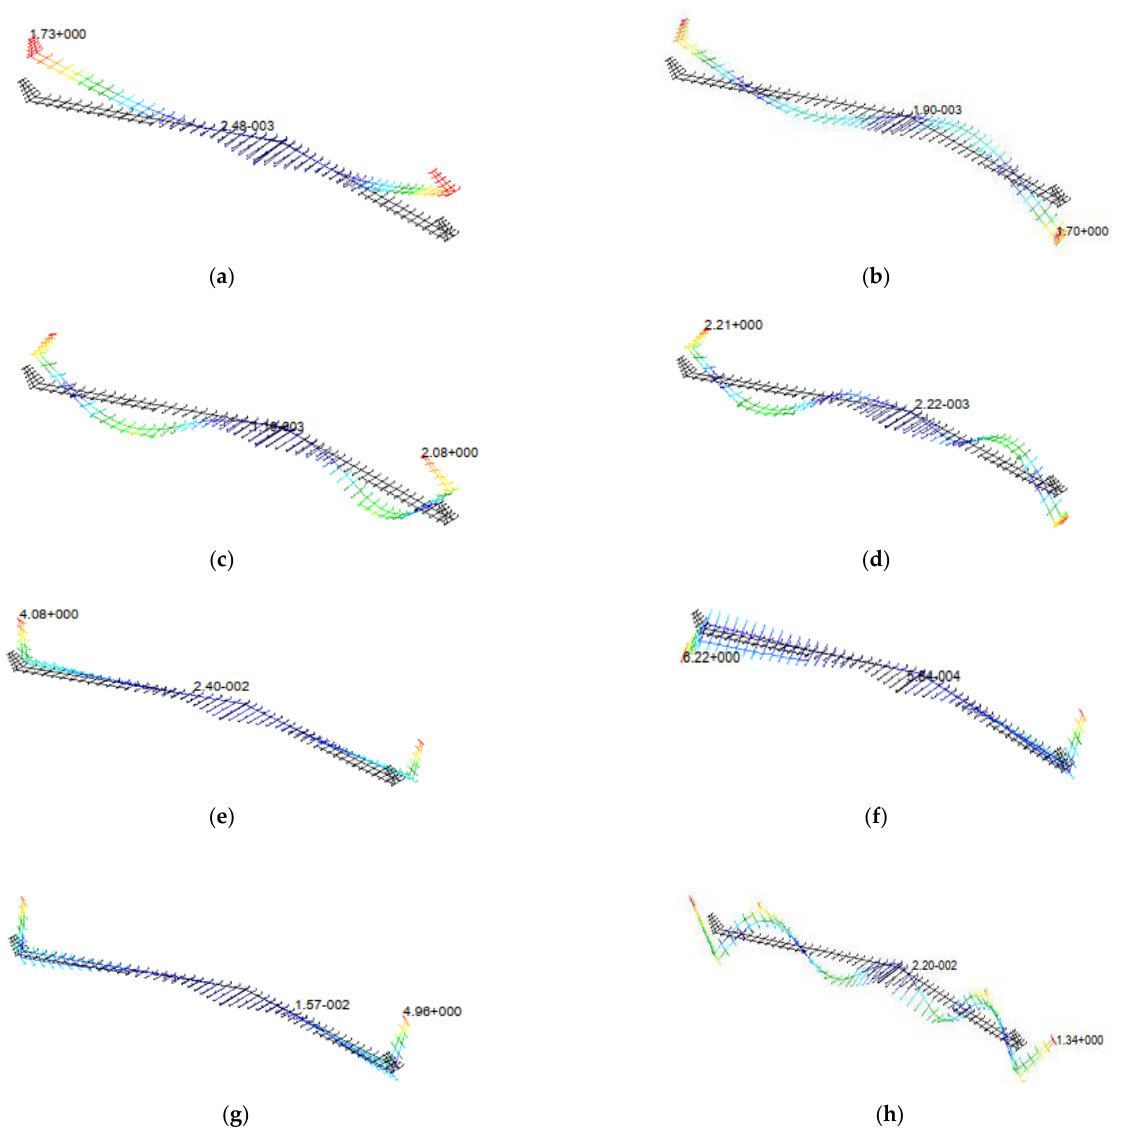
Figure 3. Modal shape of first eight elastic modes. ( a ) 1st symmetric vertical bending. ( b ) 2nd asymmetric vertical bending.